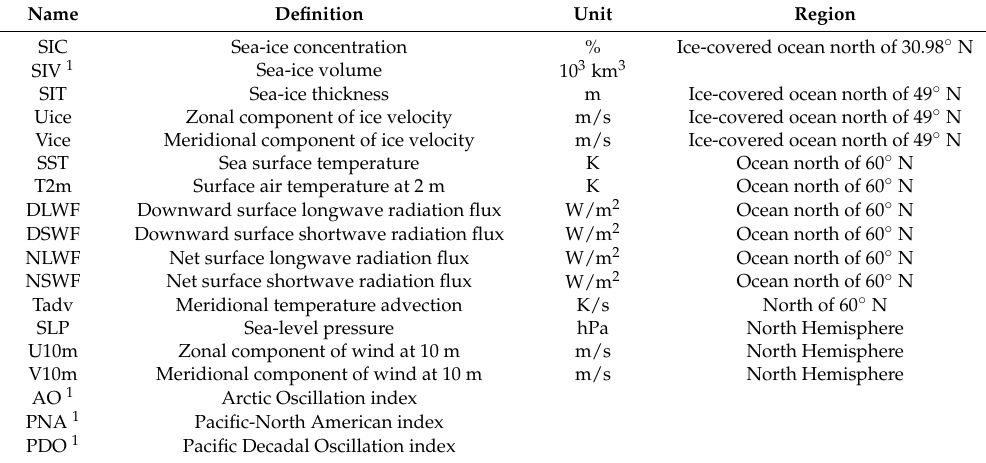
Table 1. Candidate factors associated with September Arctic sea-ice